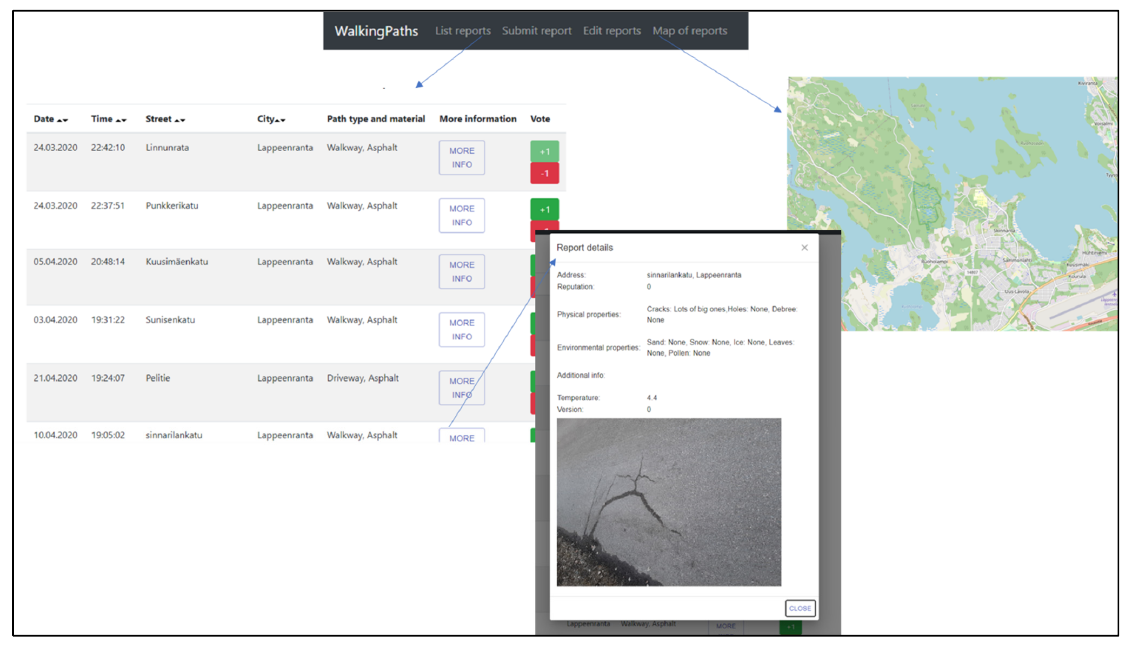
ISPRS Int. J. Geo-Inf. 2021 , 10 , x FOR PEER REVIEW Figure 3. WalkingPaths observation list and map. Figure 3. WalkingPaths observation list and map.